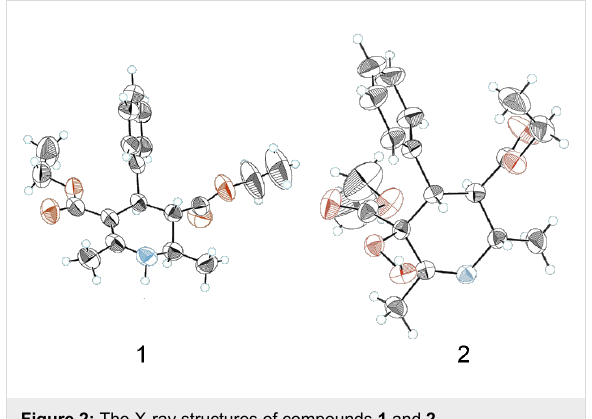
Figure 2: The X-ray structures of compounds 1 and 2